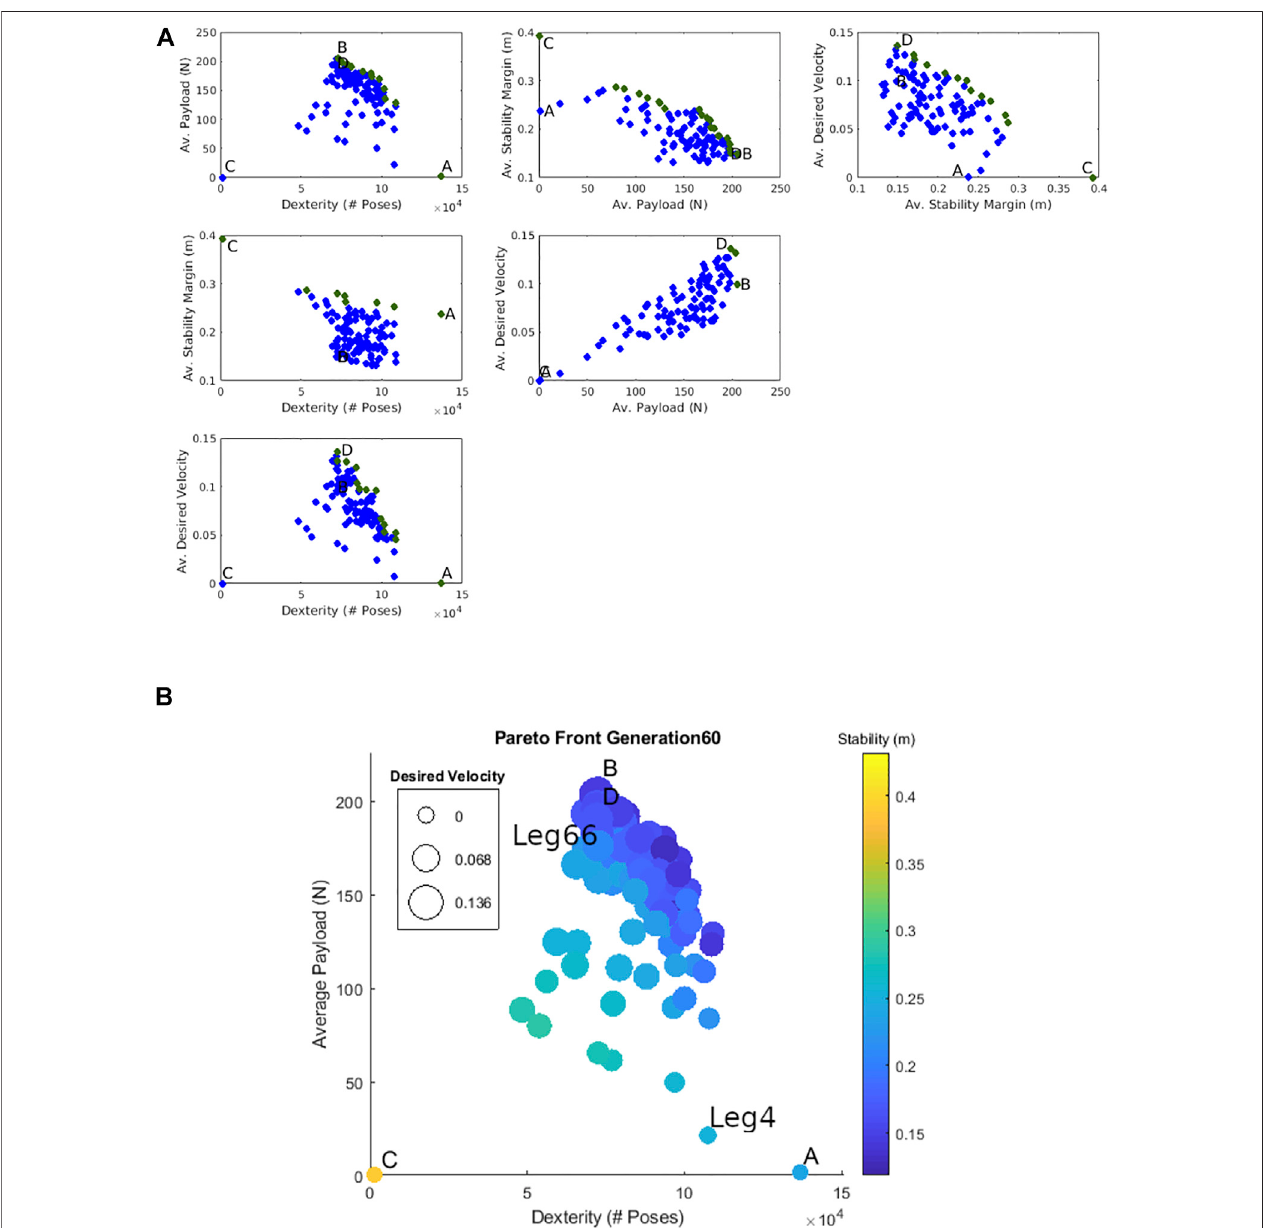
FIGURE 8 | (A) The Pareto front of the optimization after 60 generations represented in a scatter plot matrix. The robots with the best dexterity in walking region, average payload, average stability criteria, and averaged desired velocity are labeled as A, B, C, and D respectively. (B) The Pareto front of the optimization after 60 generations. The robots with the best dexterity in walking region, average payload, average stability criteria, and averaged desired velocity are labeled as A, B, C, and D respectively.